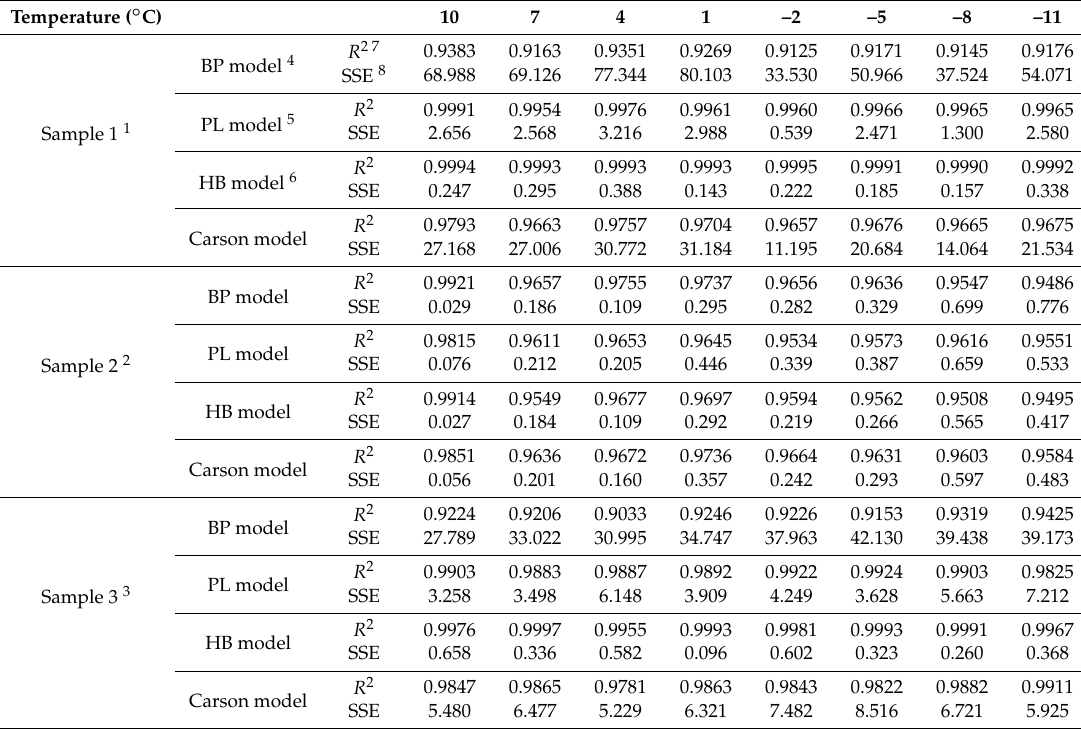
Table 4. Three kinds of polymer drilling fluid and the fit of the regression analysis R 2 and SSE.